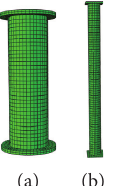
Figure 3: FEA model of short column (a) under axial compression and (b) under eccentric